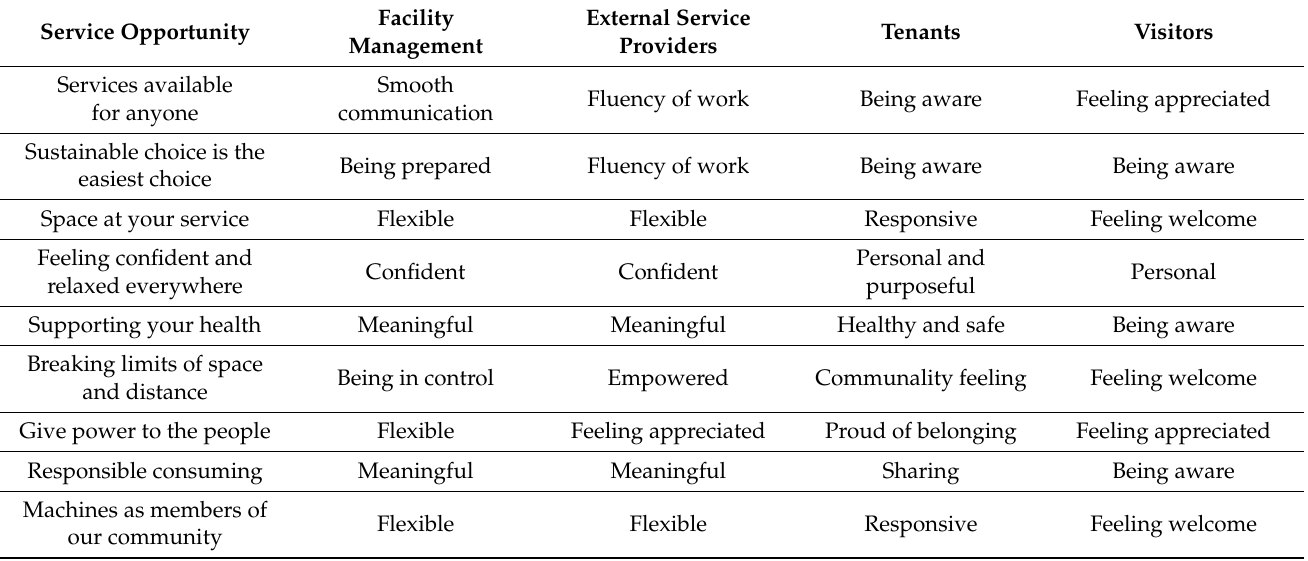
Table 2. Examples of occupant UX goals, to which the proposed services could